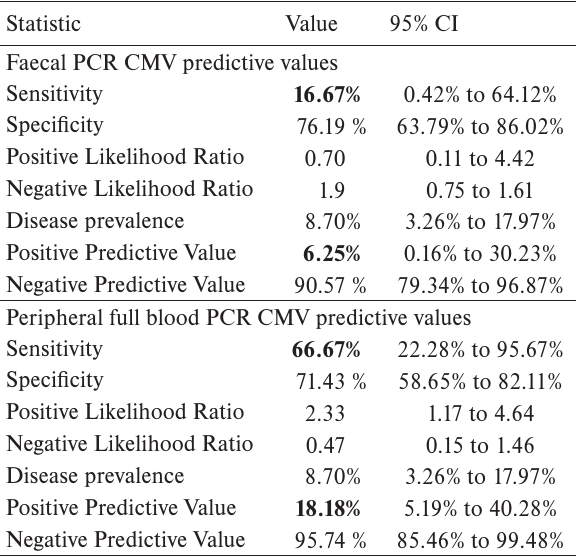
Table 3. Predictive values of blood and faecal PCR CMV samples for diagnosis of CMV enterocolitis.